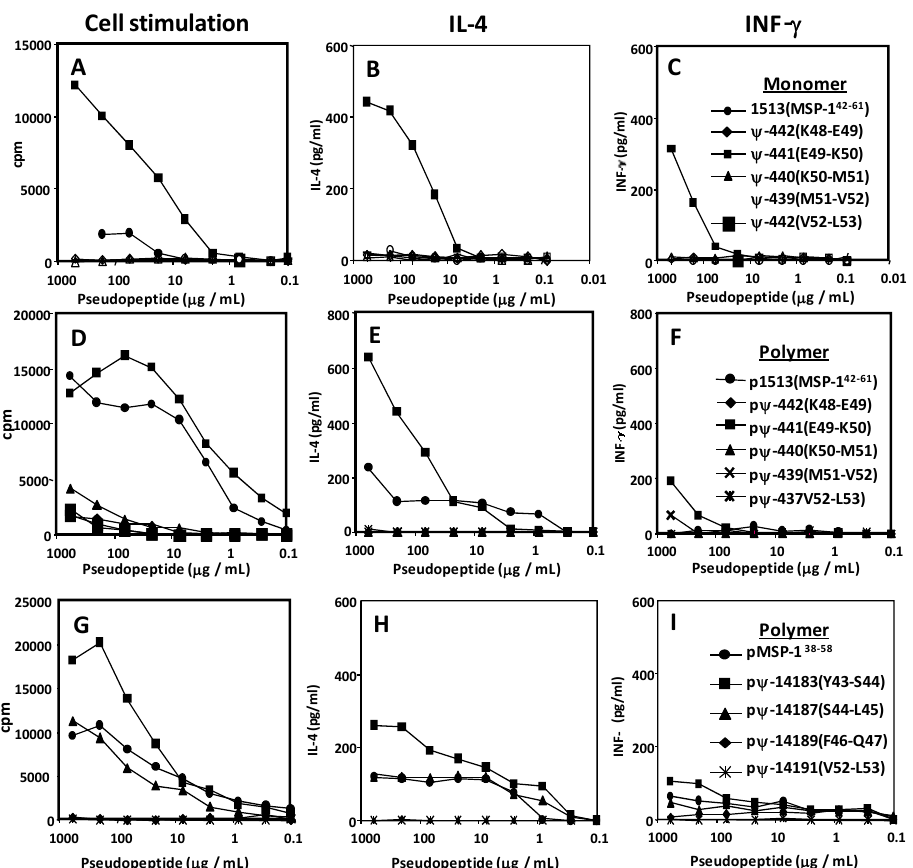
pseudopeptide analogues of the MSP-1 38-58 and MSP-1 42-61 sequences. A, B and C are stimulation patterns obtained after HLA-DR8 restricted T-cell clone stimulation with MSP- 1 42-61 pseudopeptides. D, E and F are the stimulation patterns produced after stimulation with MSP-1 38-58